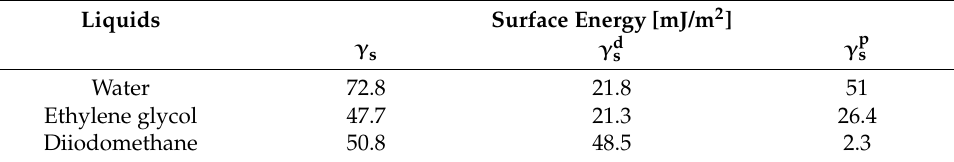
Table 3. Surface free energy of the liquids at 20 °C [30].